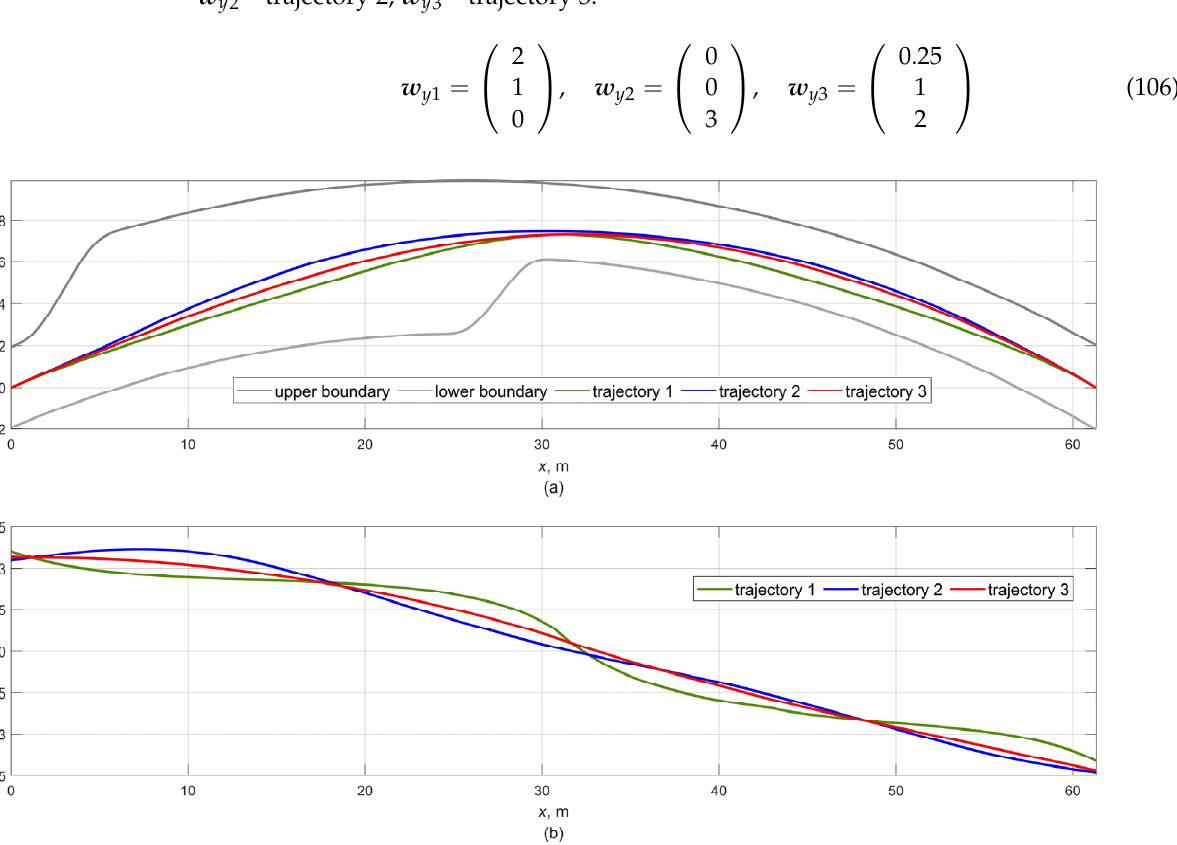
Figure 7. Variants of vehicle motion geometry depending on the priority criteria: ( a ) mass center trajectories and ( b ) yaw angles.